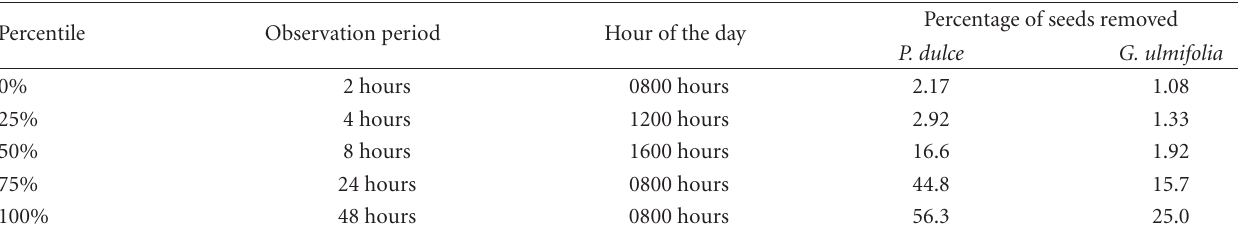
Table 3: Percentiles for the total removal percentage of Pithecellobium dulce and Guazuma ulmifolia nonmyrmecochorous seeds in six cattle pastures in Cauca and